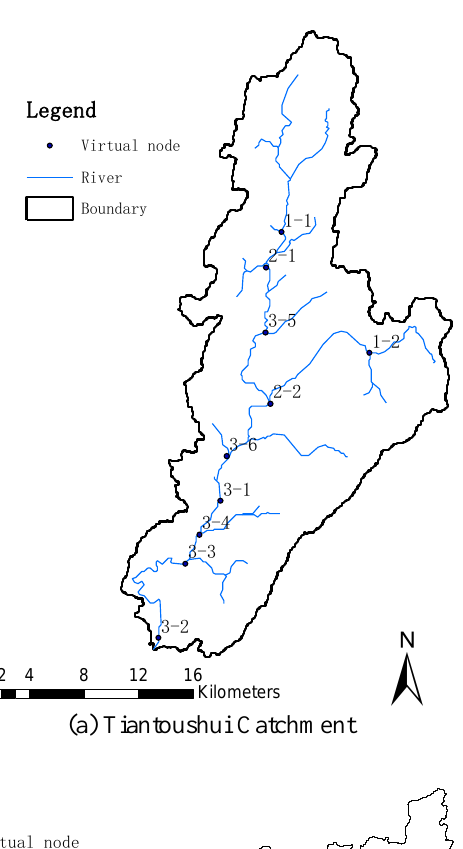
Figure 5. The evolution process of parameter optimization with PSO in Tiantoushui catchment: (a) evolution of objective function and (b) evolution of parameters.